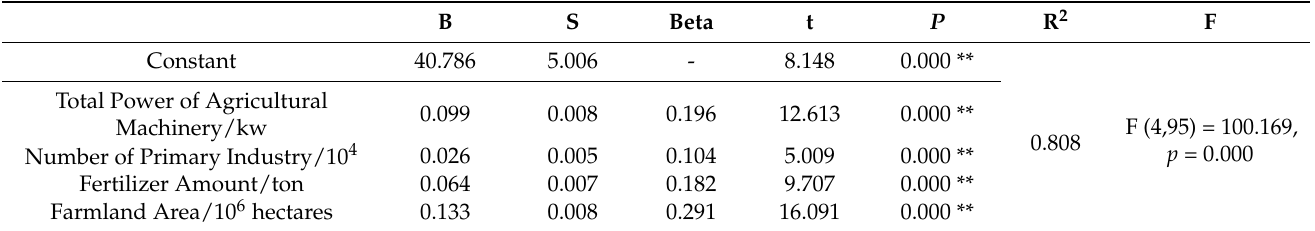
Table 2. Ridge regression analysis